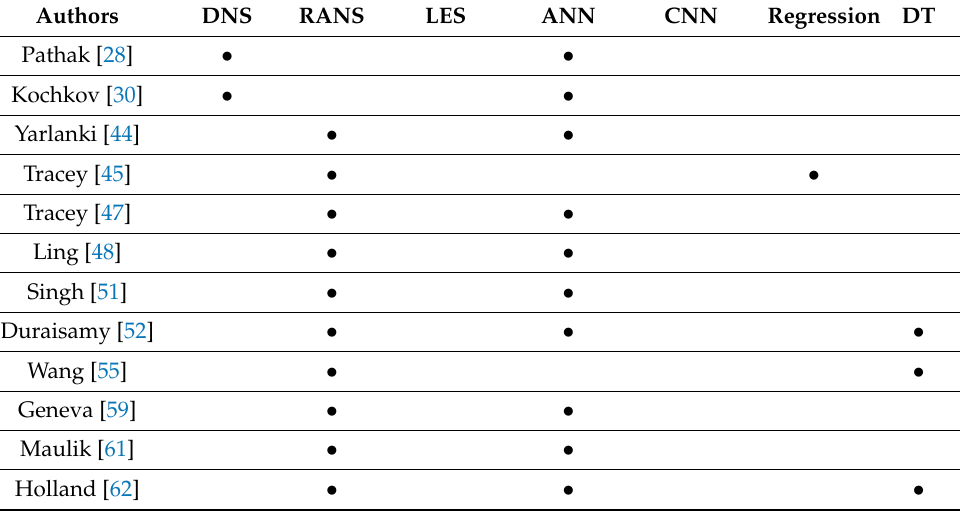
Table 1. The list of selected papers with their corresponding methodology (marked with a bullet in the appropriate